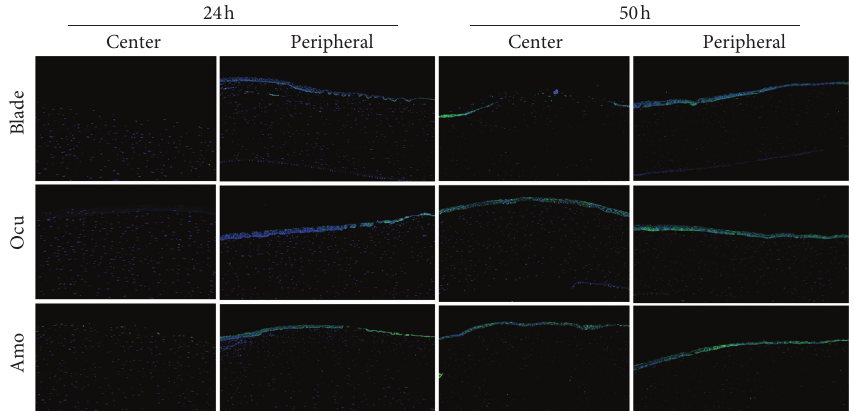
Figure 3: Phosphorylated heat shock protein 27 (pHSP27) staining at 24 and 50 hours after epithelial removal in the three